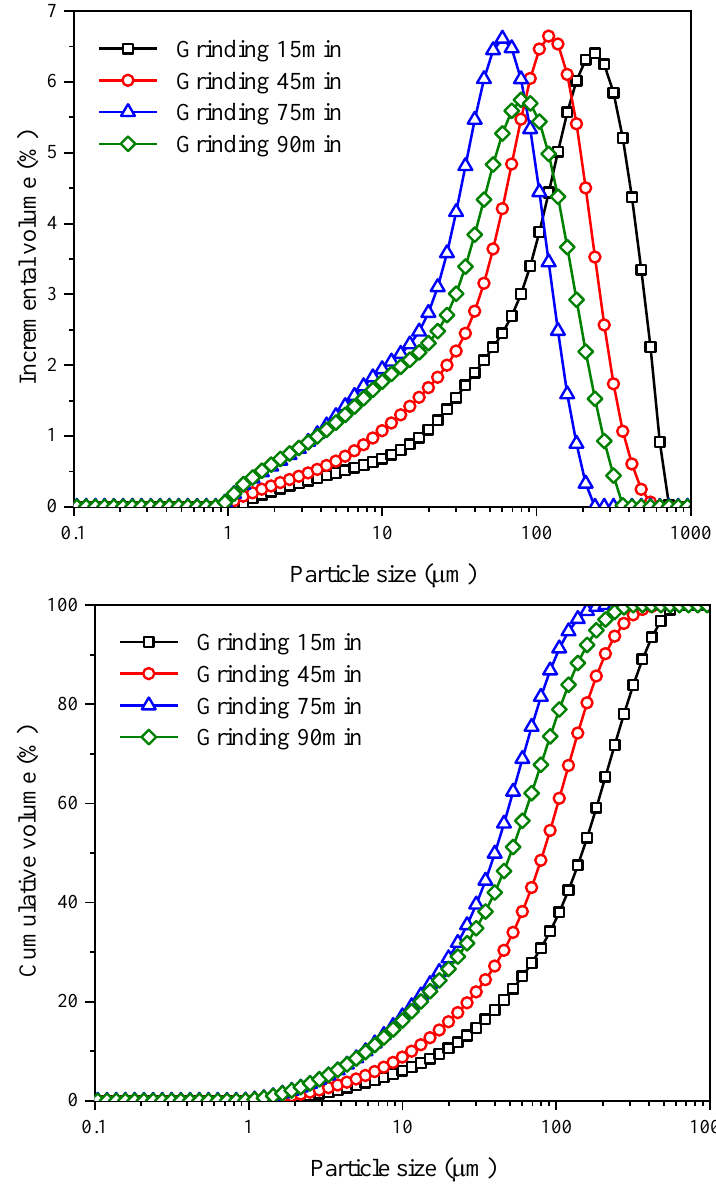
Figure 3. The PSD curve of CGS in different grinding time.